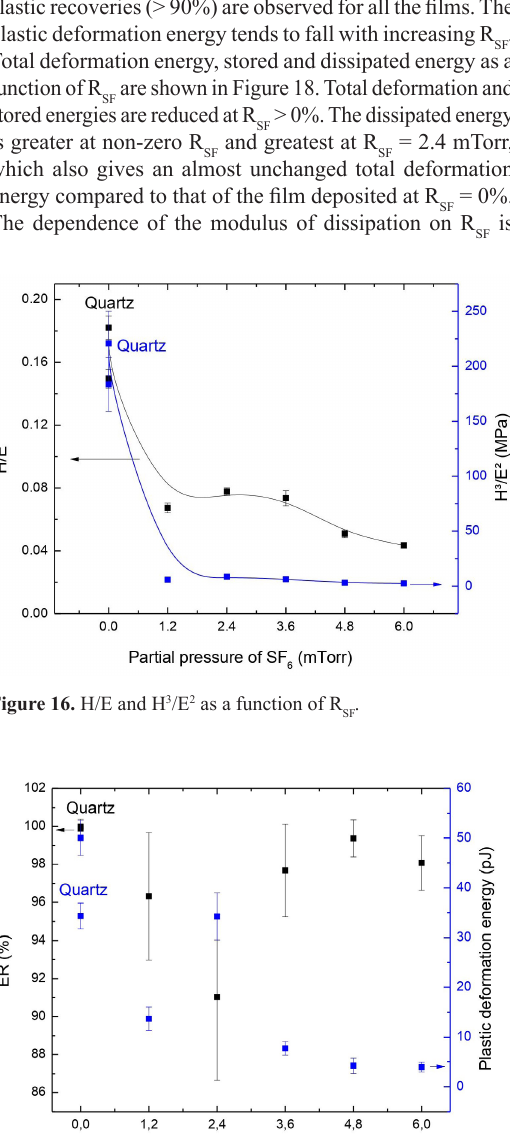
Figure 15. Stiffness as a function of R